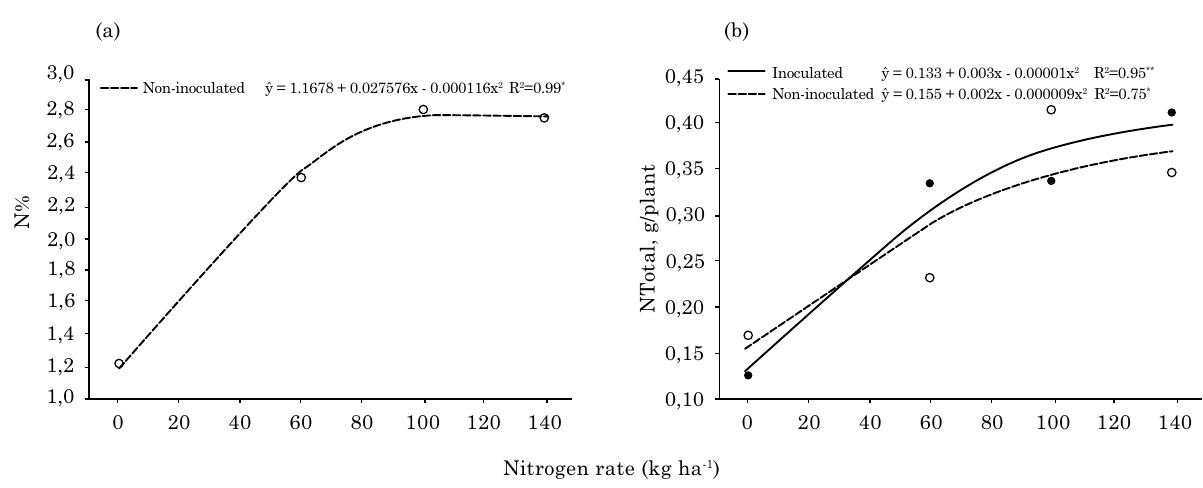
Figure 1. Nitrogen percentage (N%) (a) and nitrogen total (NTotal) (b) in maize shoots, with and without inoculation (ZAE94) and different N rates, in Vitória da Conquista, average of five